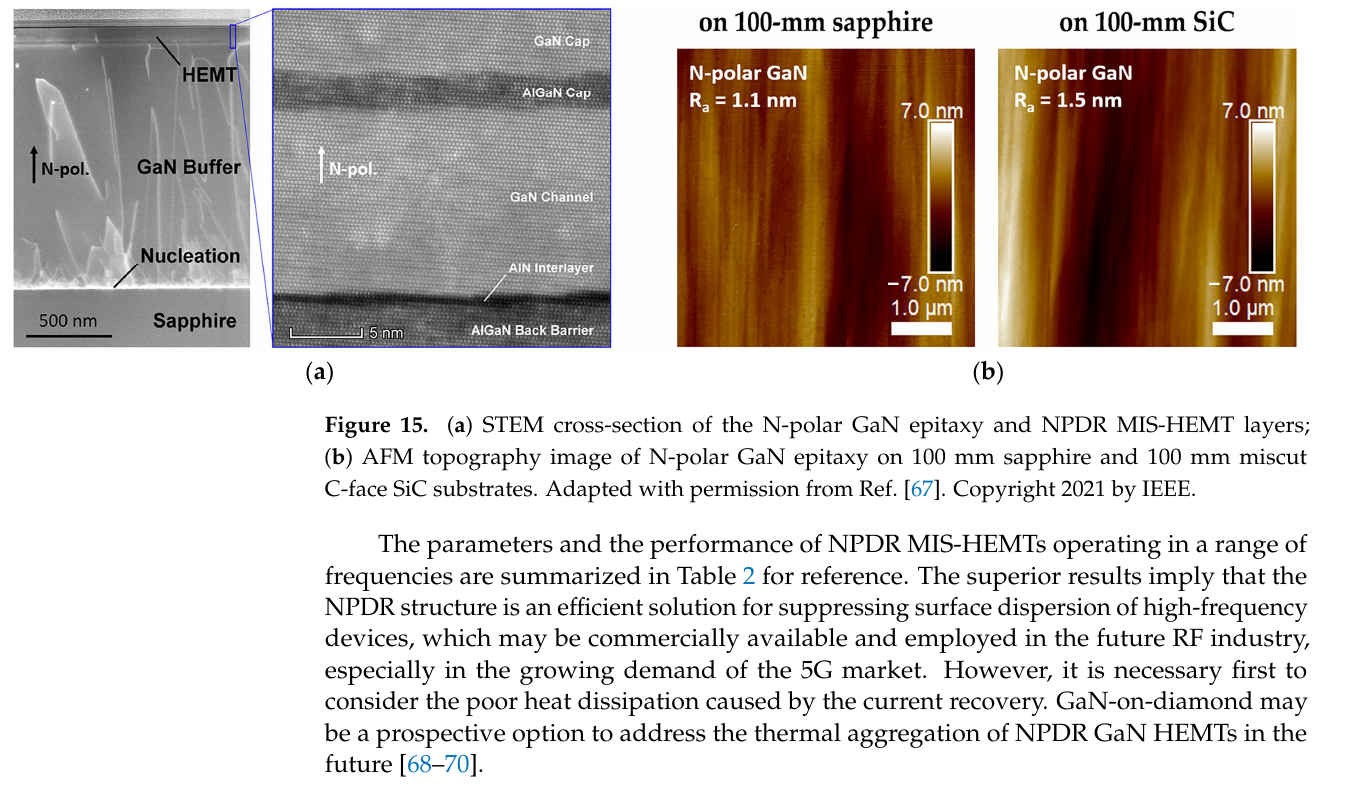
Table 2. Characterization of NPDR MIS-HEMTs applied to various wave bands, including epitaxial structures, output performances, and dispersion suppression.